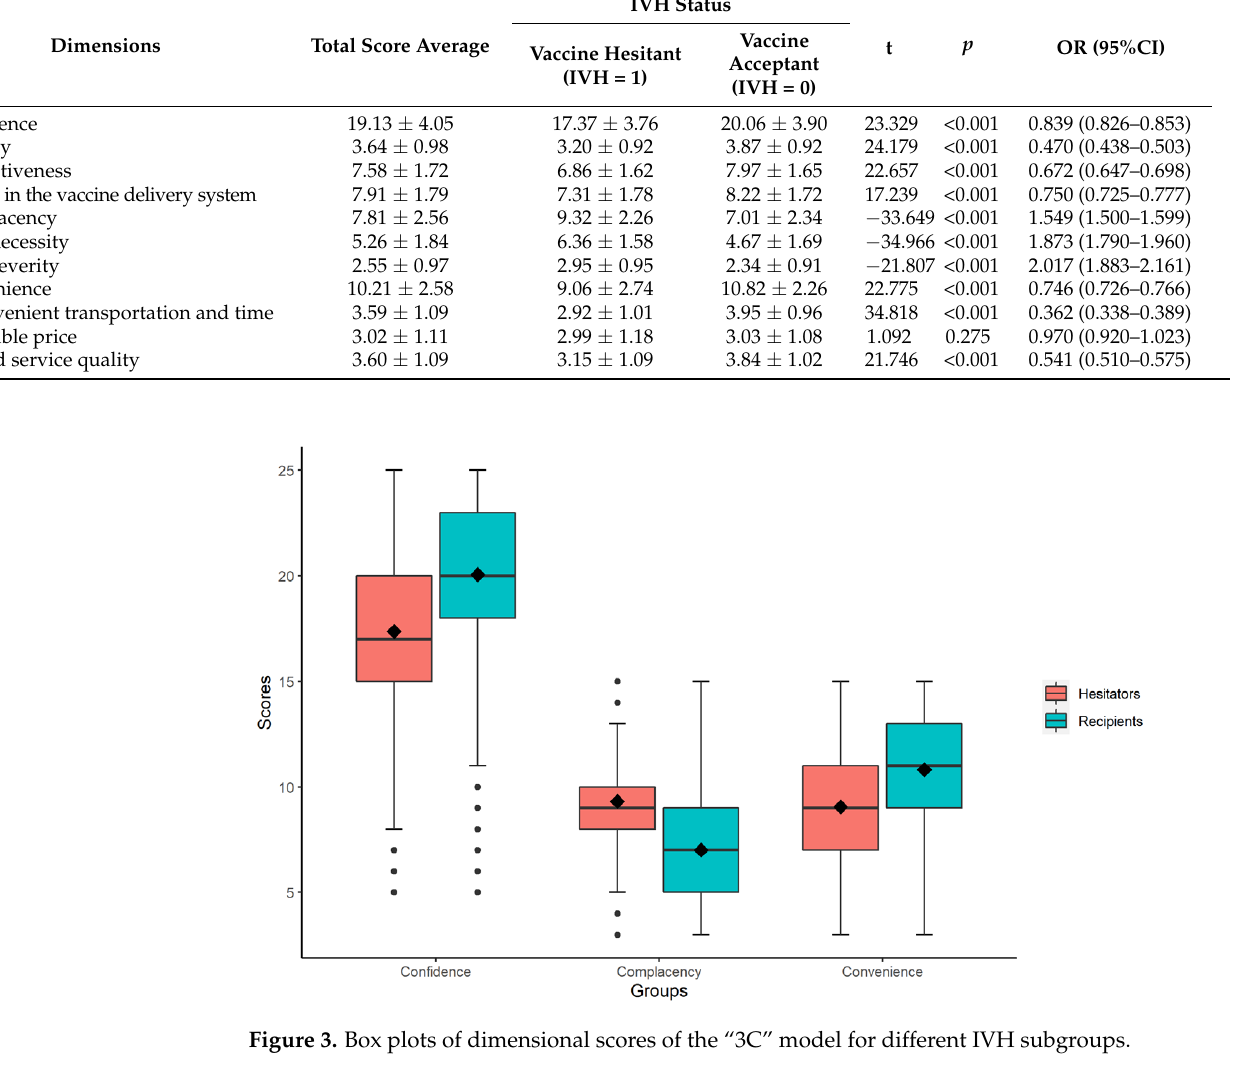
Table 3. Logistic regression analysis of predictors of parental IVH.